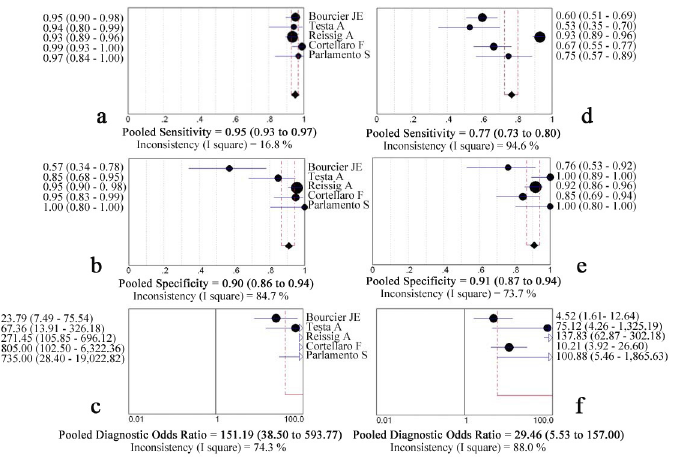
Fig 2. Forest plot for pooled sensitivity, specificity and diagnostic odds ratio of lung ultrasonography (a, b, c) and chest radiography (d, e, f) for the detection of pneumonia compared with hospital discharge